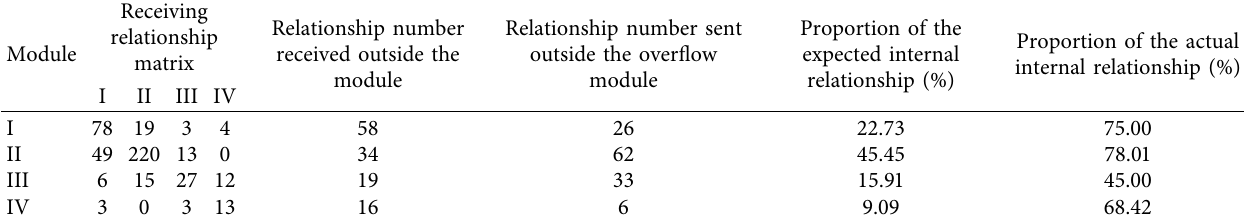
Table 5: Module overflow effect of the spatial correlation network of the innovation efficiency of the IM enterprises. Module